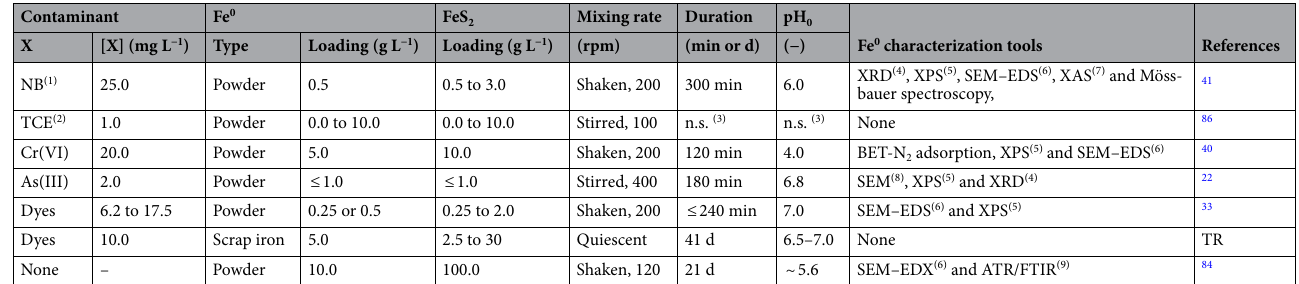
Table 6. Experimental conditions of selected studies using the Fe 0 /FeS 2 /H 2 O system. X stands for the tested contaminant and [X] its initial concentration. It is seen that only this study used quiescent systems and the longest experimental duration. This study has also performed no solid phase Fe 0 analysis. (1) Nitrobenzene; (2) Carbon tetrachloride; (3) n.s. = not specified; (4) XRD = X-ray diffraction; (5) XPS = X-ray photoelectron spectroscopy; (6) SEM–EDS = scanning electron microscopy—energy dispersive X-ray spectroscopy; (7) XAS = X-ray absorption spectroscopy; (8) SEM = scanning electron microscopy; (9) ATR/FTIR = attenuated total reflection /Fourier transform infrared spectroscopy; TR = This